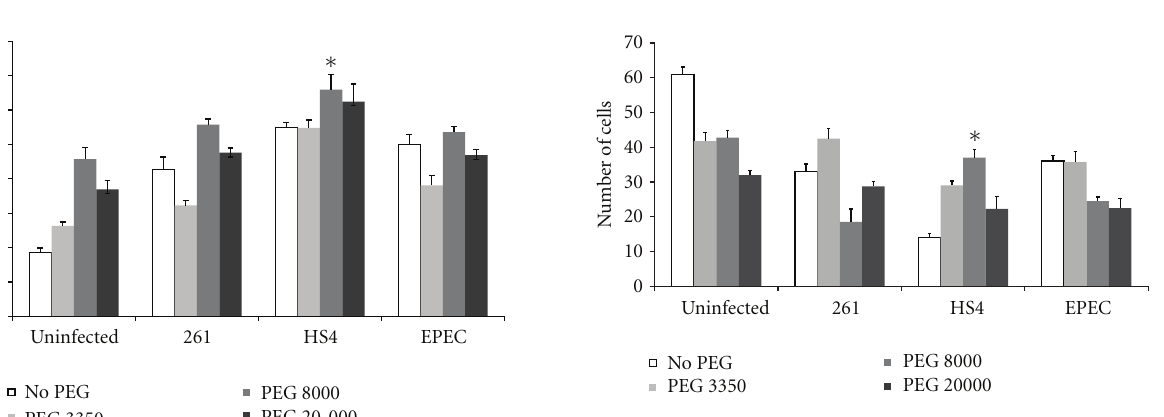
Figure 5: Quantitative analysis of cluster density. Cell density analysis was performed as described in Methods. Cell density de- creased in response to independent treatment with any of the three PEGs or bacterial strains. When treated with PEG 3350 and the two commensal bacterial strains, there was an increase in cell density. Cell density recovery was most persevered when treated with PEG 8000 and HS4. PEG 20,000 did not preserve cell density when cells were treated with any of the three bacterial strains. Standard Student’s t -test was applied to the samples and the P < 0 . 05 were obtained for samples treated with PEG 8000 and HS4 indicated by an asterisk ( ∗